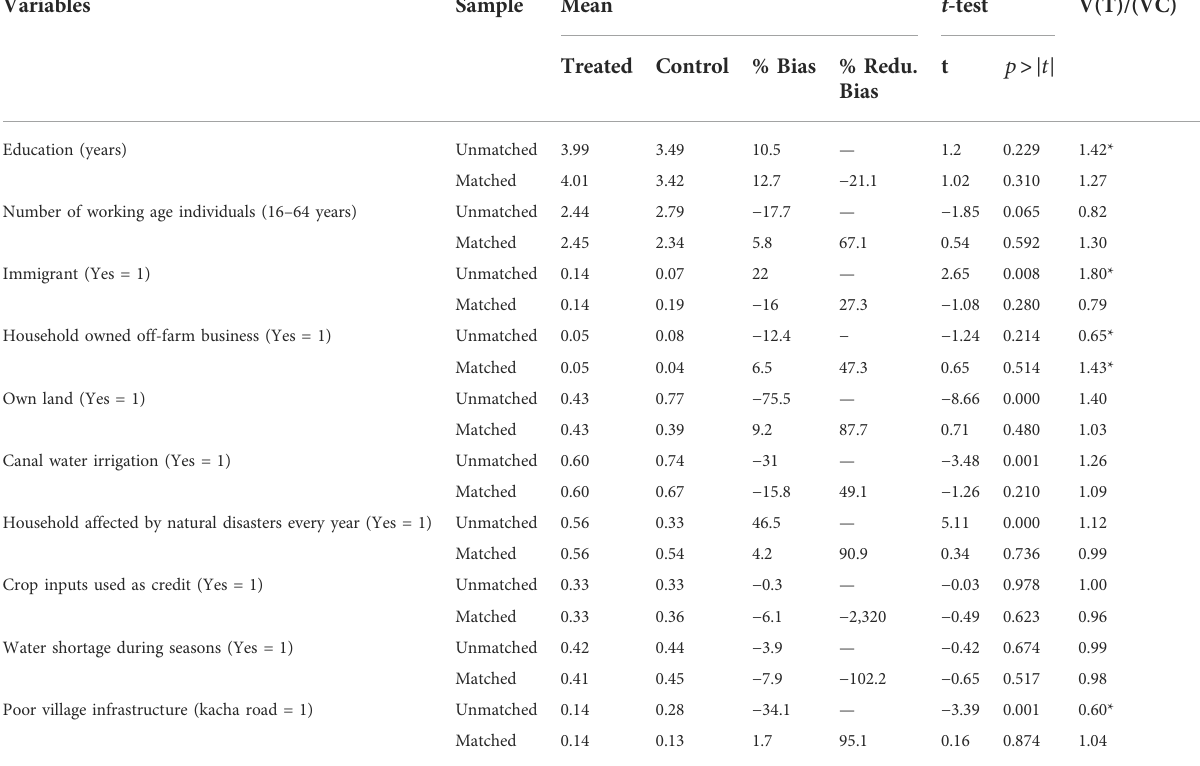
TABLE 8 Results of balancing tests before and after the nearest neighbor 1-to-1 matching with replacement (For exit farming).